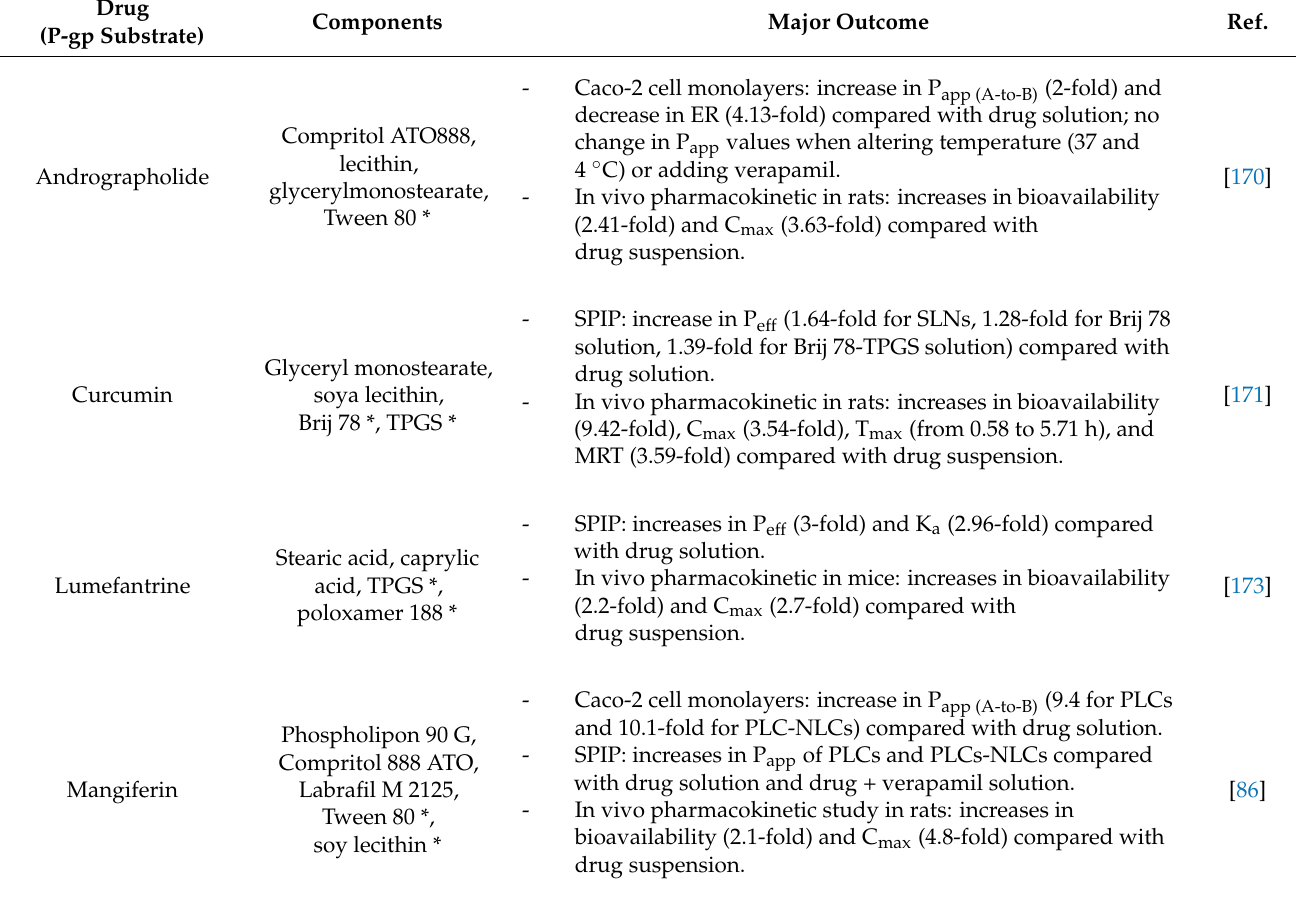
Table 3. SLNs and NLCs with P-gp inhibitory